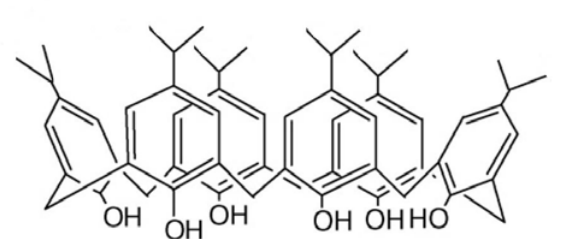
Figure 1. Chemical structure of p